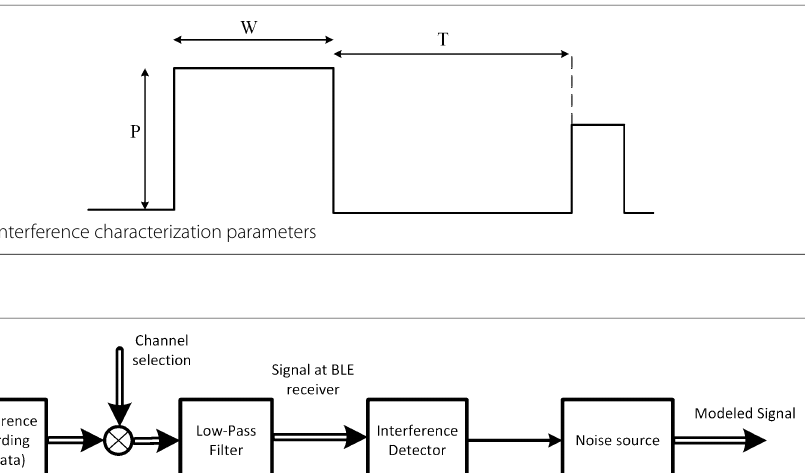
Fig. 9 Process flow graph of IQ-based interference model